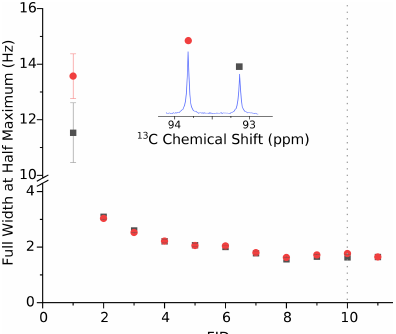
Figure A1. Full width at half maximum of the 13 C doublet due to the carbonyl 13 C atom of pyruvate hydrate for the data shown in Fig. 3. The linewidth of both peaks of > 10Hz in the first scan is attributed to a gas bubble that rises up the NMR tube during the first scan. The second spectrum, recorded 3.75s after the sample ejection, displays a substantially improved resolution of 3.2Hz. Over time the resolution improves further and is better than 2Hz 14s after the beginning of the NMR acquisition. Note that there is no significant change in resolution when the back pressure is released 20s after the beginning of data acquisition (i.e., near the beginning of FID no. 10, marked with the dotted line).